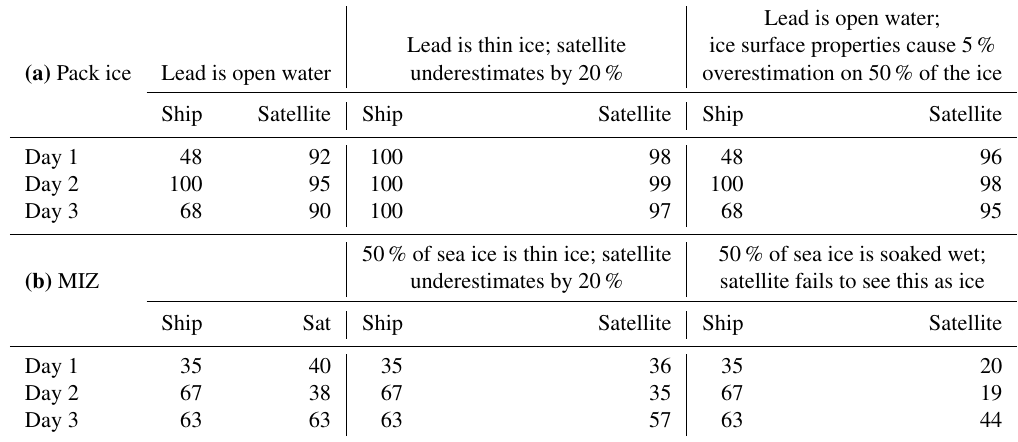
Table 7. Summary of hypothetic daily average sea-ice concentrations from Fig. 17 for the pack ice case (a) and the marginal ice zone (MIZ) (b) . The left two columns show sea-ice concentrations as shown in Fig. 17; the middle two columns show the effect of sea-ice concentration underestimation for thin ice; and the right two columns show the effect of sea-ice concentration overestimation, e.g. thick ice with a wet snow cover (top), or of sea-ice concentration underestimation, e.g. MIZ during end of summer (bottom). Lead is open water; Lead is thin ice; satellite ice surface properties cause 5% (a) Pack ice Lead is open water underestimates by 20% overestimation on 50% of the ice Ship Satellite Ship Satellite Ship Satellite Day 1 48 92 100 98